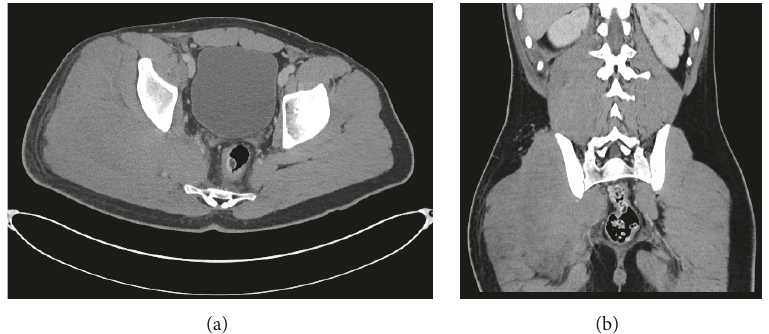
Figure 3: Axial (a) and coronal contrast enhanced CT (b) images of the abdomen and pelvis from the 17-year-old boy in case 1. There is striking asymmetric enlargement of the right gluteal and paraspinal muscles, isodense to adjacent muscle.